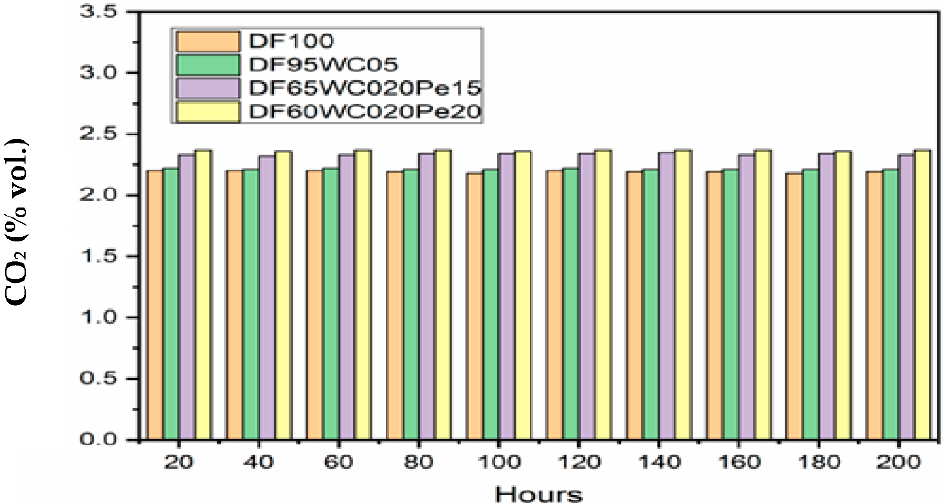
Figure 6. Carbon dioxide emissions versus engine running hours.